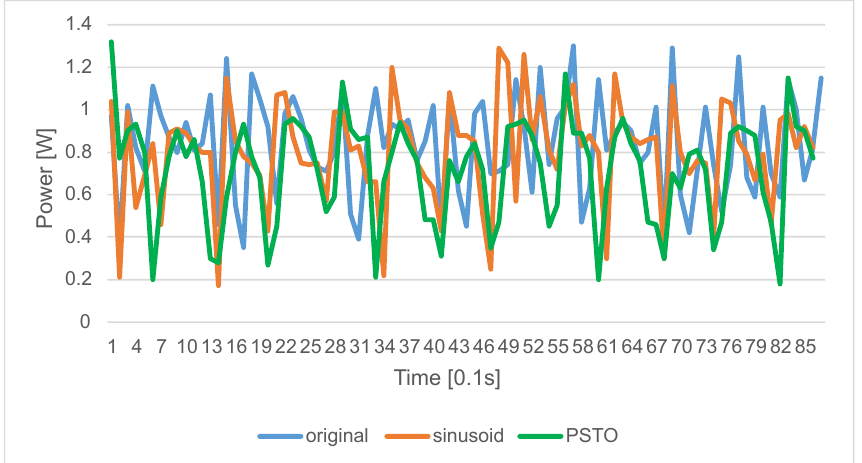
Figure 5. The comparison of power consumption per time step of three methods in the real world. PSTO has a lower average power consumption than both original and sinusoid functions when the speed is 0.12 m/s and leg length is 1